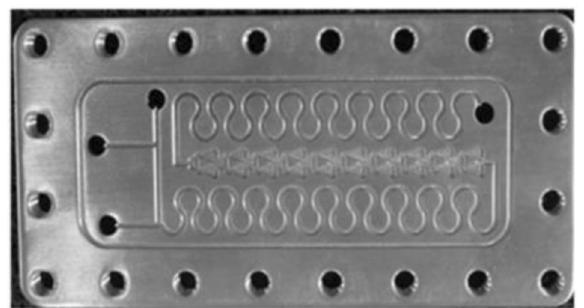
Fig. 1 AMAR1 microreactor (https://amarequip.com/continuous fl ow